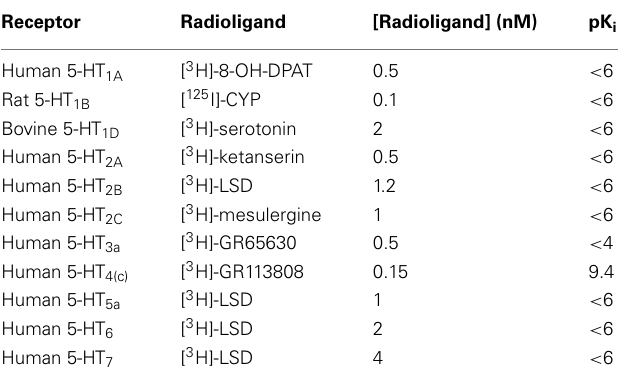
Table 2 | Binding affinity (pK i ) ofTD-8954 at 5-HT receptor subtypes.